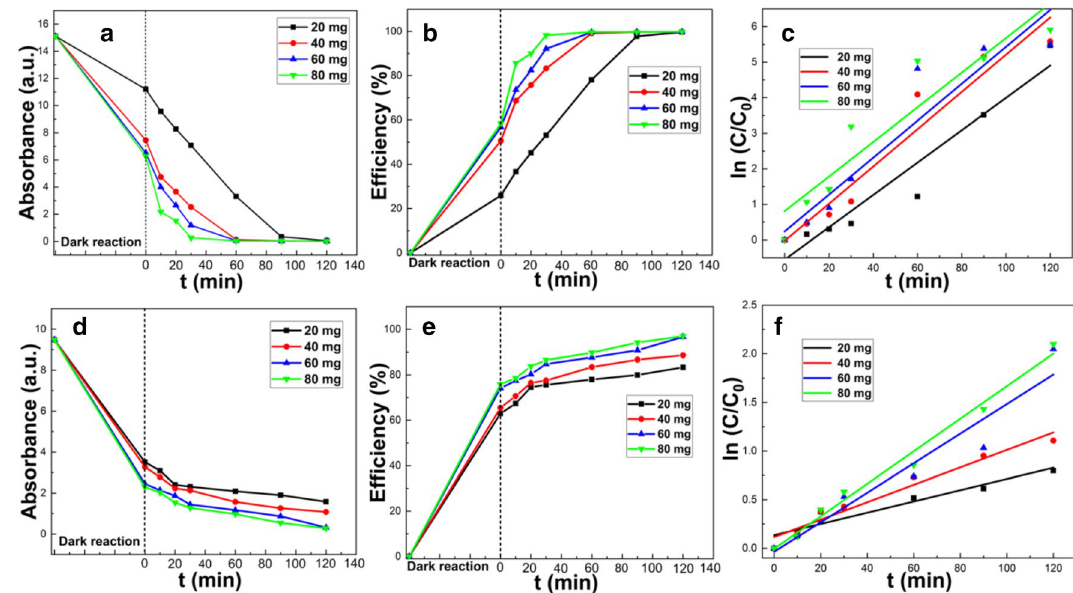
Figure 5. Photocatalytic experiment of MB ( a – c ) and CR ( d – f ) with different doses of clam shell at 1000 °C ( a,d ) curve of absorbance with time, ( b , e ) curve of removal rate with time, ( c , f ) plot of log of concentration with